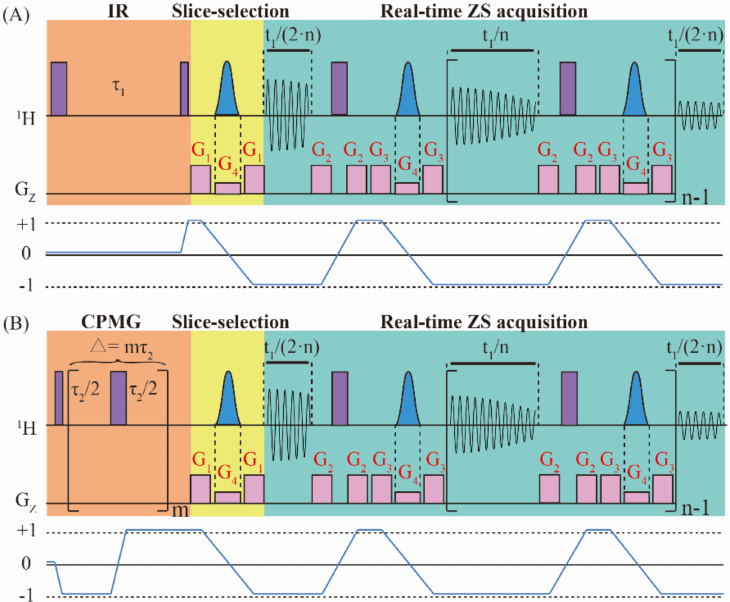
Figure 1. Pulse sequence diagrams of ( A ) real-time ZS-IR and ( B ) real-time ZS-CPMG experiments for measuring T 1 and T 2 relaxation times, respectively. The real-time ZS-IR sequence consists of IR and the real-time ZS module, including slice-selection and real-time ZS acquisition. The real-time ZS-CPMG sequence consists of CPMG and the real-time ZS module. Purple full vertical bars stand for nonselective π / 2 and π pulses, blue Gauss-shaped pulses are Gauss-shaped selective pulses and they are applied with the weak gradients, G 4 . G 1 , G 2 , and G 3 are coherence selection gradients. In the IR module, τ 1 is the incremental inversion recovery delay for the T 1 relaxation evolution process. In the CPMG module, ∆ = m τ 2 is the incremental spin-echo delay for the T 2 relaxation process. In the acquisition period, t 1 , acquisition chunks and ZS pure-shift modules are repeated n times for extracting pure shift information in a single excitation. The coherence transfer pathways for real-time ZS-IR and real-time ZS-CPMG sequences are given to illustrate the coherence states of spins. Relevant parameters are further defined and explained in the